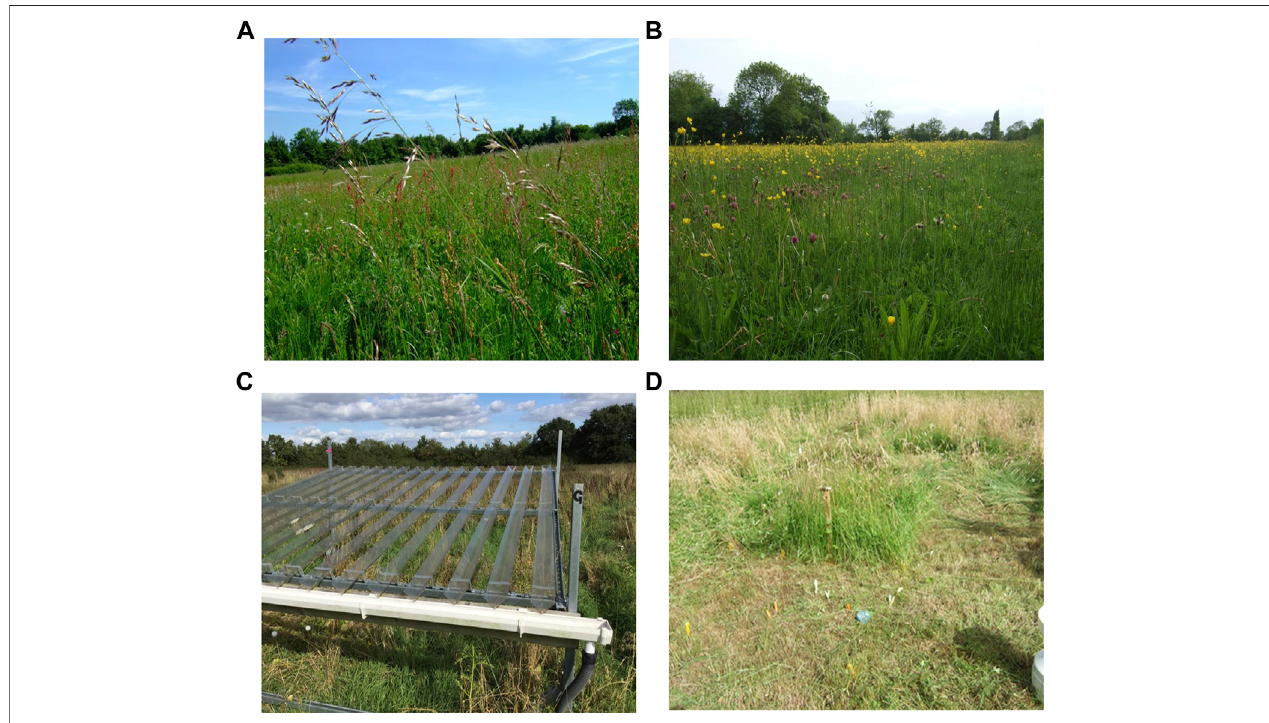
FIGURE 2 | (A) Vegetation at UWE, (B) Vegetation at OWP, (C) One of the Reduced Rainfall plots at UWE, note metal frame, transparent “ V ” shaped gutters and pipe to carry intercepted water away from the plot, (D) A partly cut Control plot at OWP, note rain gauge in bottom right corner. The coloured markers indicate where samples have been taken. Blue circle is top of Adcon soil moisture sensor. Photographs © S.